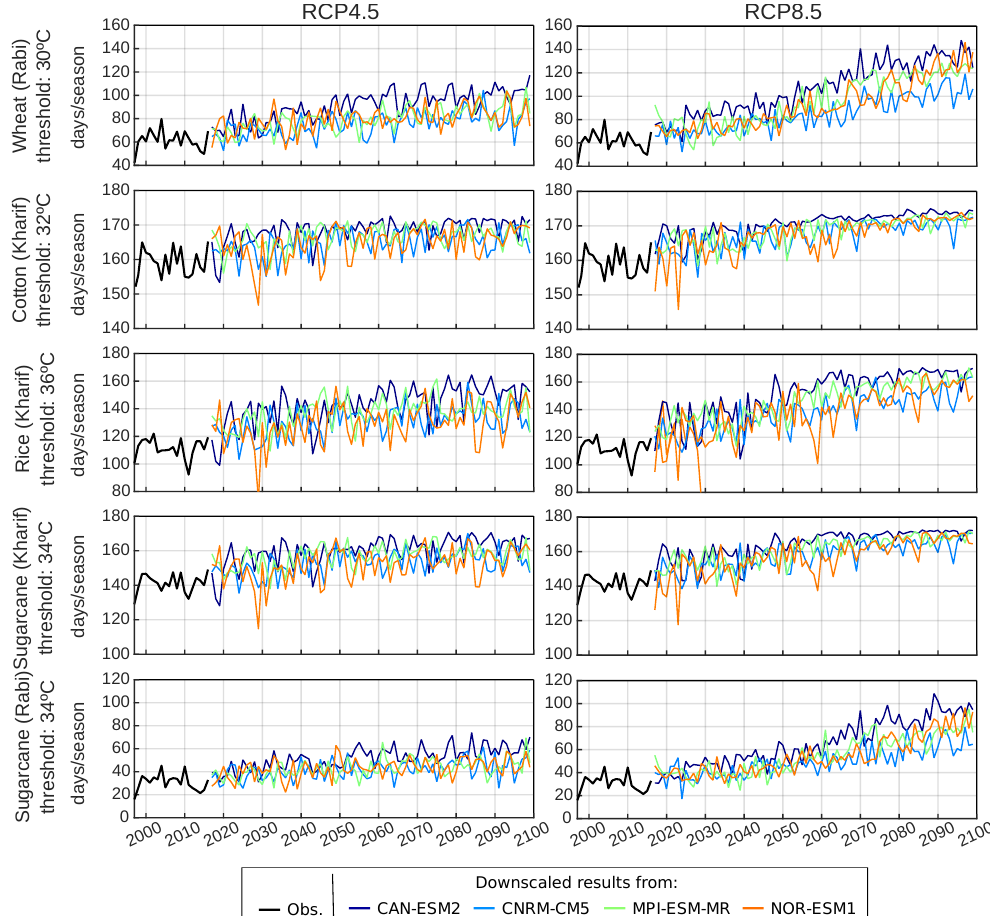
Figure 7. Annual projections of the number of “hot” days averaged over the 15 PMD stations up to 2100, as given by the different ESMs (in colors) under the RCP4.5 and RCP8.5 scenarios ( left and right column, respectively). The threshold defining a “hot” day depends on each particular crop (in rows), being 30/32/36/34 ◦ C for wheat/cotton/rice/sugarcane. Only the growing season of each crop is considered in this analysis: Rabi for wheat and Kharif for rice and cotton. For sugarcane, which grows in the two seasons, results are shown for both Kharif and Rabi (last two